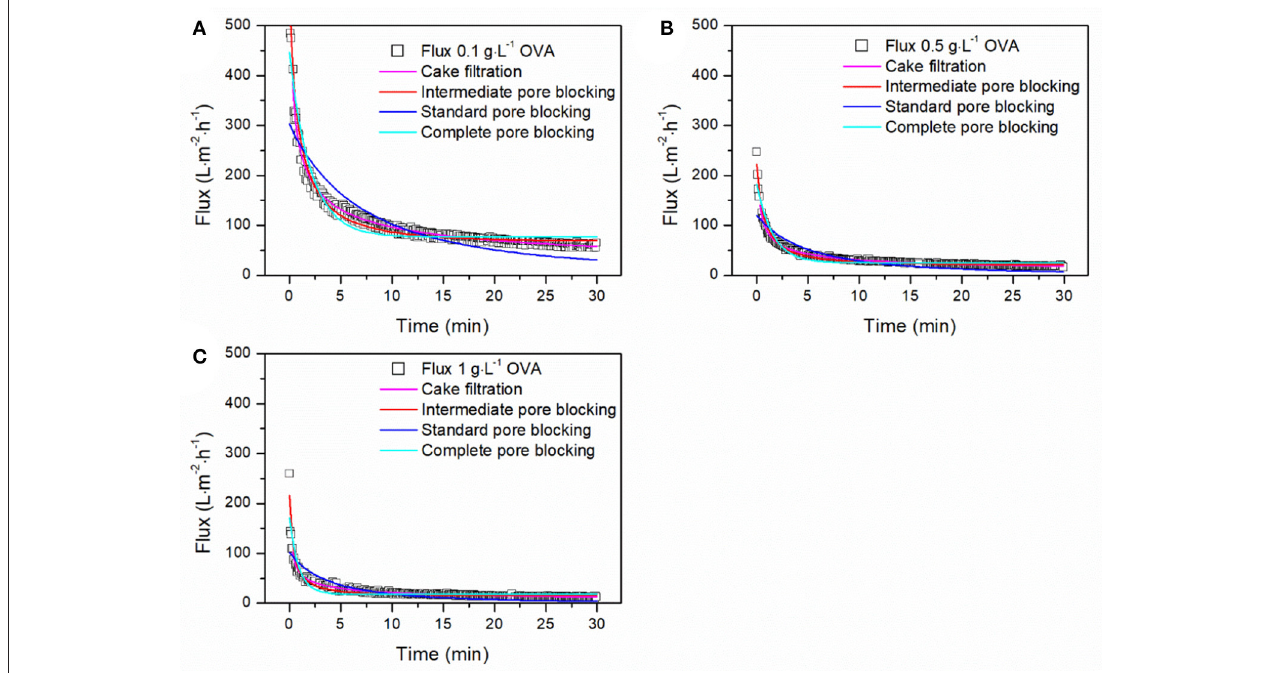
FIGURE 6 | Fitting of fouling models to the filtration data for different concentrations of OVA aggregates. (A) Filtration of 0.1 g · L − 1 OVA aggregates. (B) Filtration of 0.5 g · L − 1 OVA aggregates. (C) Filtration of 1 g · L − 1 OVA aggregates. Filtration was carried out using a 50nm cut-off ceramic membrane in total recycling mode at 1.5 bar and 28 ◦